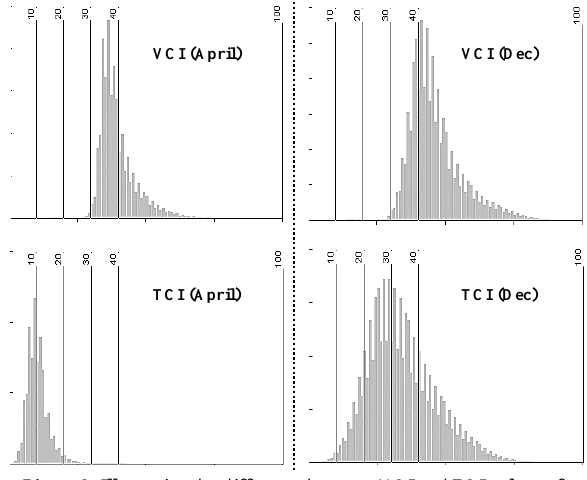
Figure 6: Illustrating the difference between VCI and TCI values of different time zone for 2015 (as per Table